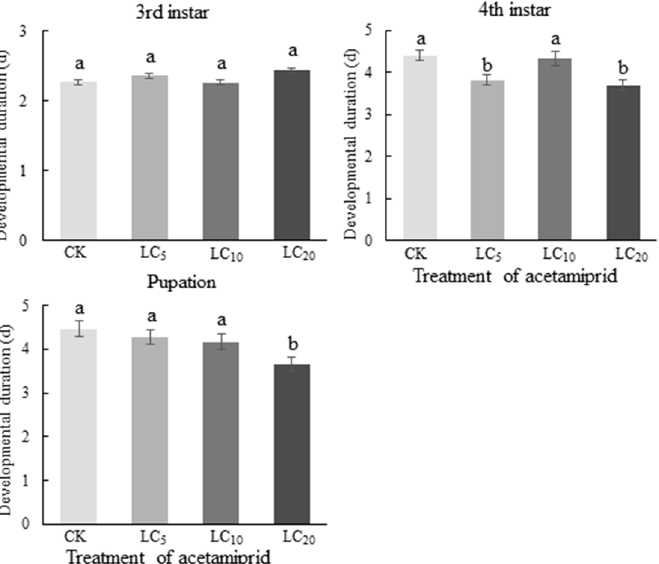
Figure 3. Effects of acetamiprid on developmental duration of C. septempunctata within the 3rd instar larval stage (mean ± SE). The same column followed by different letters is significantly different based on ANOVA using Tukey’s LSD test ( p < 0.05).